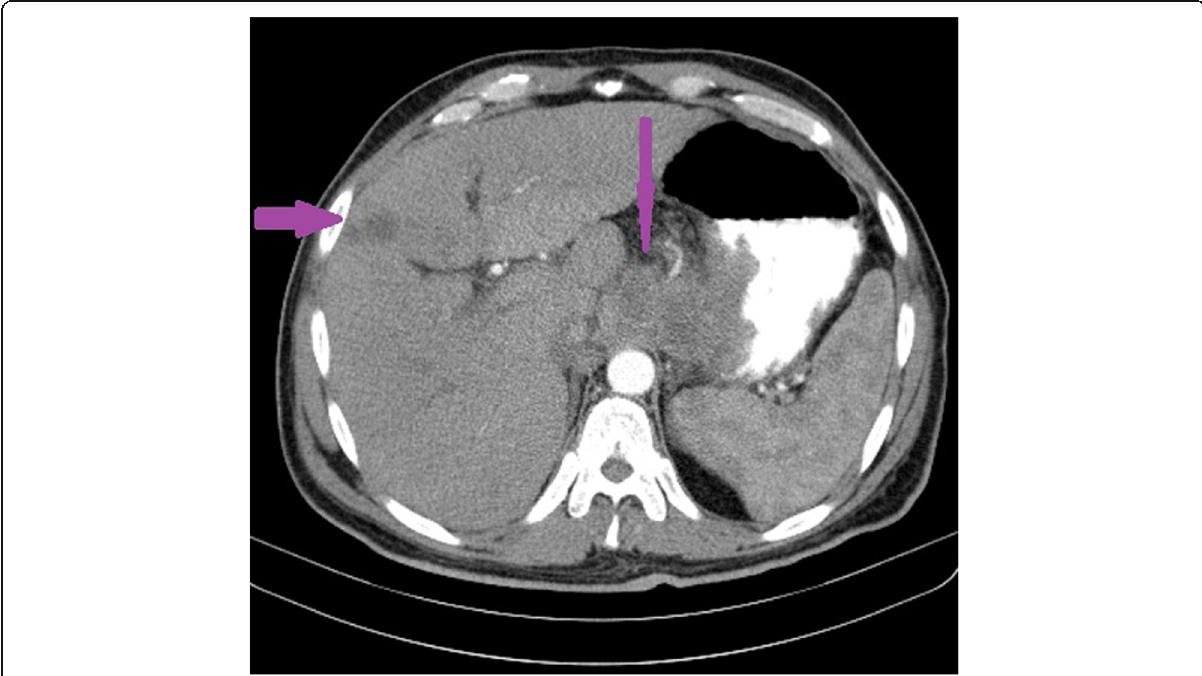
Fig. 1 A 56-year-old male presented with hematemesis for 1 month, a contrast-enhanced CT (arterial phase with oral contrast) axial scans show diffuse relatively enhanced thickness of the lesser curvature reaching gastro esophageal junction, not reaching esophagus, its maximum thickness about 2 cm. Furthermore, there is a hypoechoic round hepatic focal lesion found. Final diagnosis: stage T4NxM1 gastric carcinoma